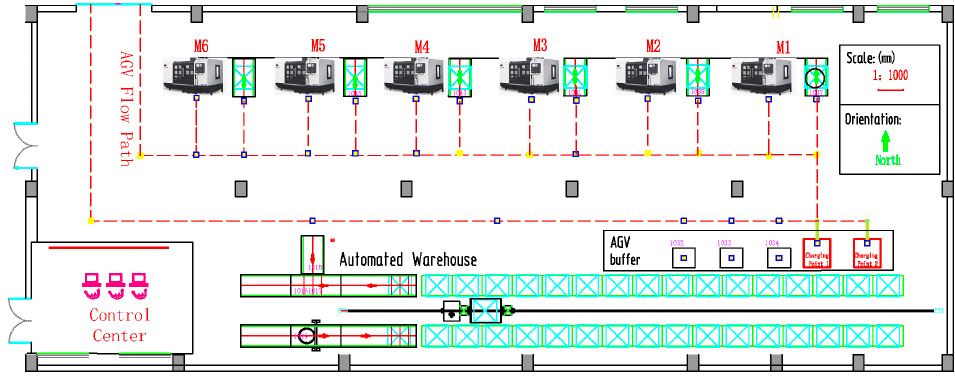
Figure 3. The layout of the hub workshop.